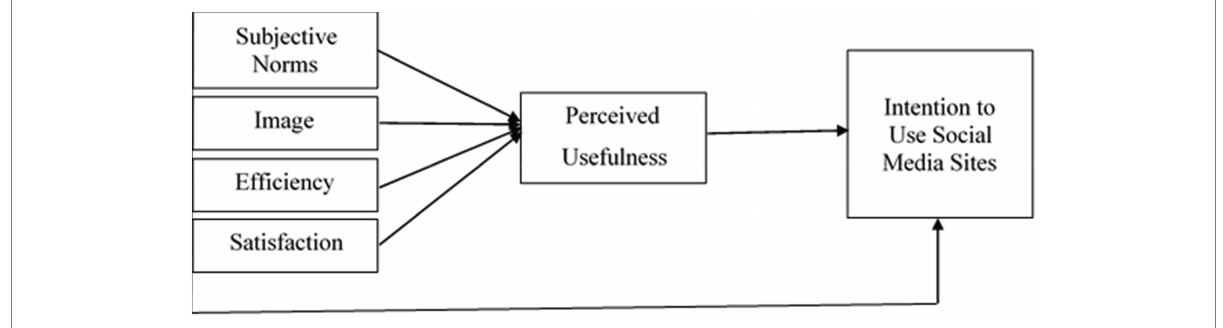
FIGURE 1 Conceptual